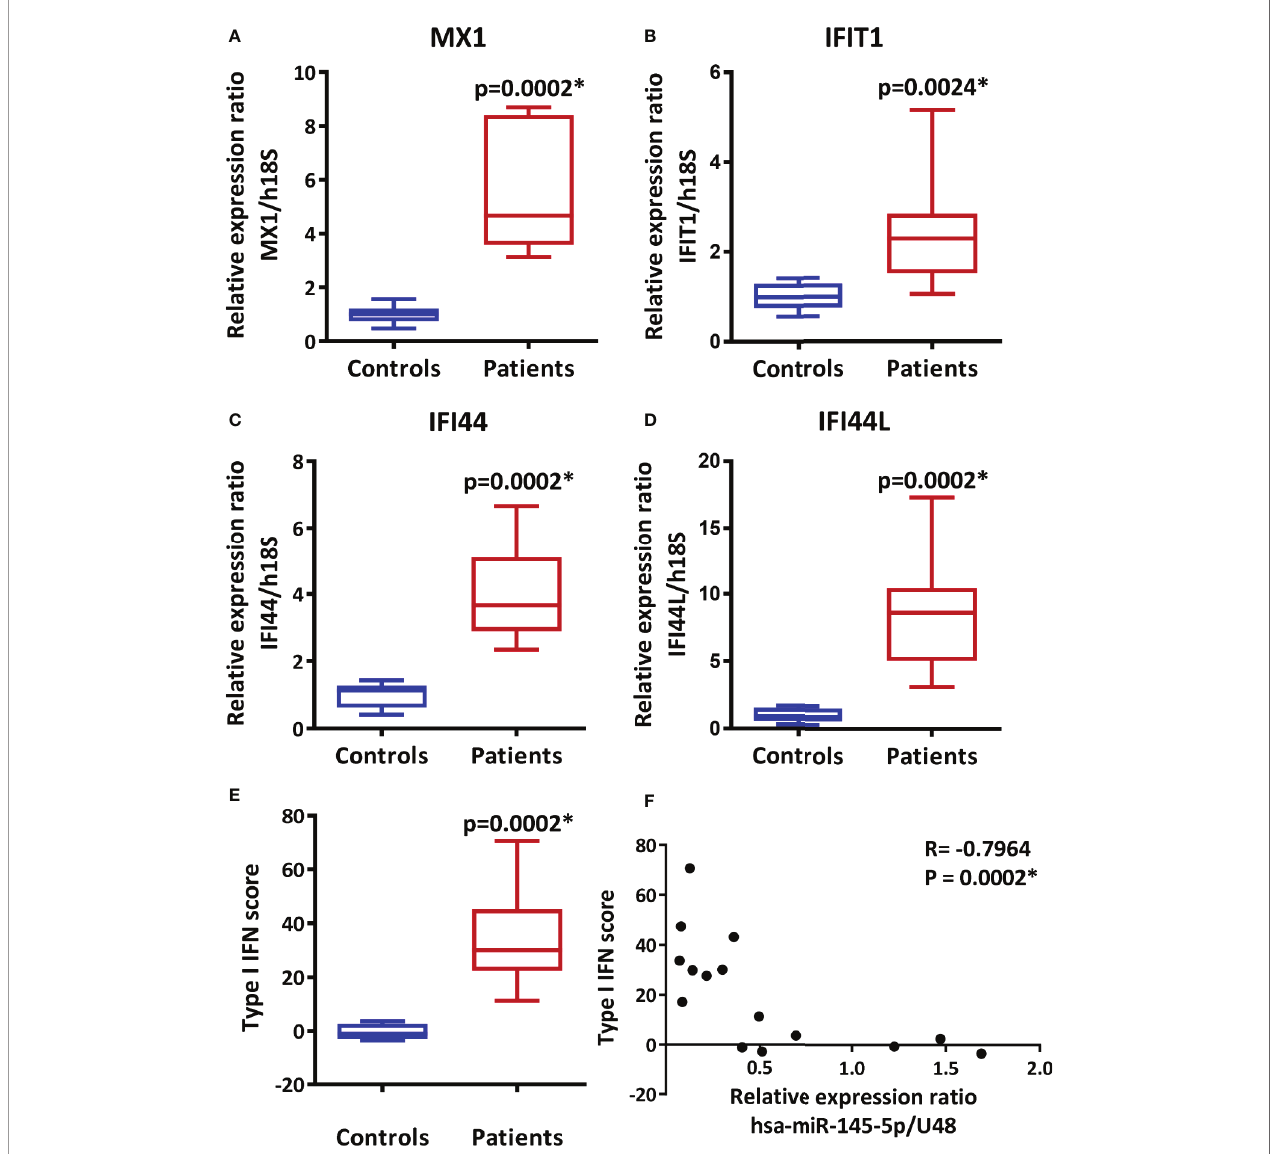
FIGURE 2 | Overexpression of MX1, IFIT1, IFI44, and IFI44L and increased type I IFN score in LSG from SS-patients. Relative expression ratios of MX1 (A) , IFIT1 (B) , IFI44 (C) and IFI44L (D) in 9 SS-patients and 6 controls. h18S was used as a housekeeping gene. (E) Type I IFN score was calculated by summing the MX1, IFIT1, IFI44, and IFI44L standarized expression levels. (F) Spearman correlation between hsa-miR-145-5p levels and type I IFN score in SS-patients and controls. Data are representative of at least three independent measurements. (*) p-value ≤ 0.05 was considered signi fi